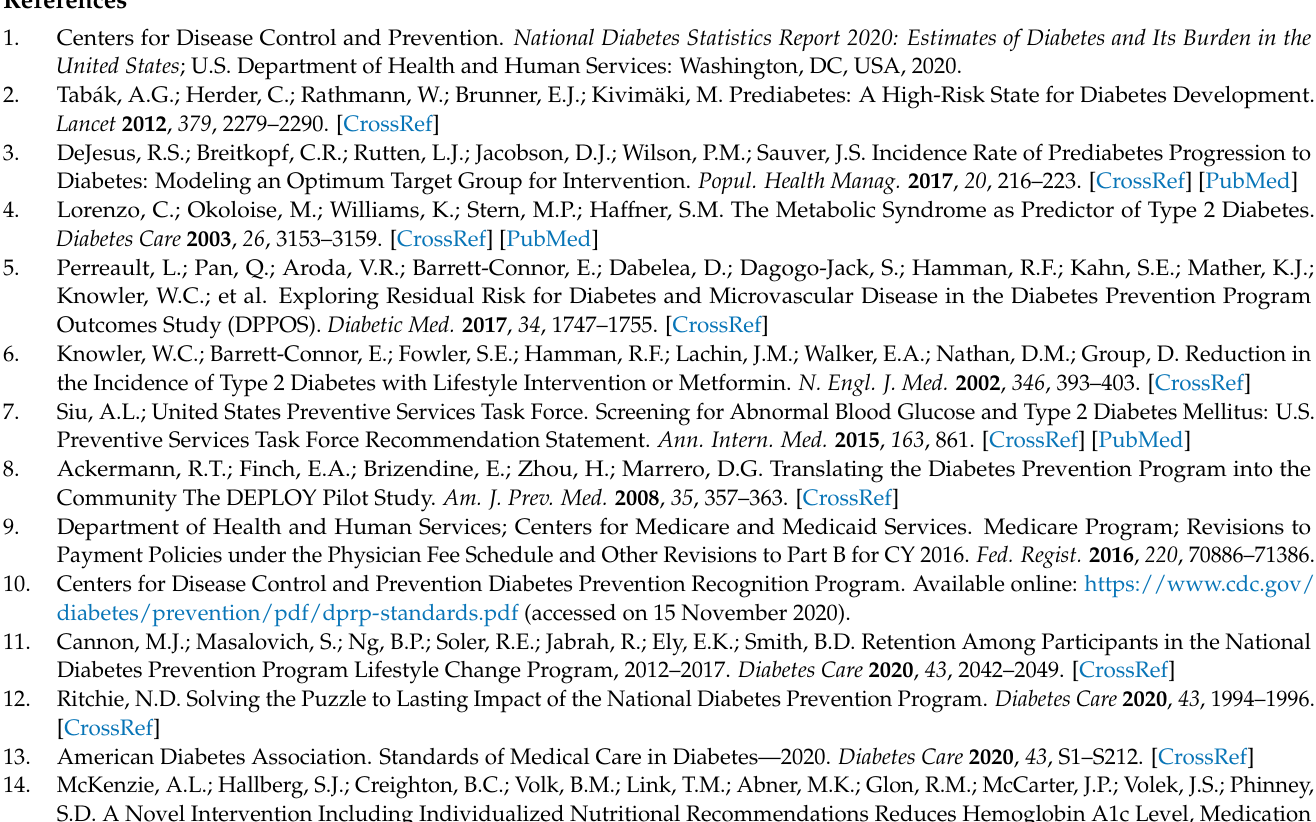
Table S3: Baseline characteristics of participants and comparison of completers and